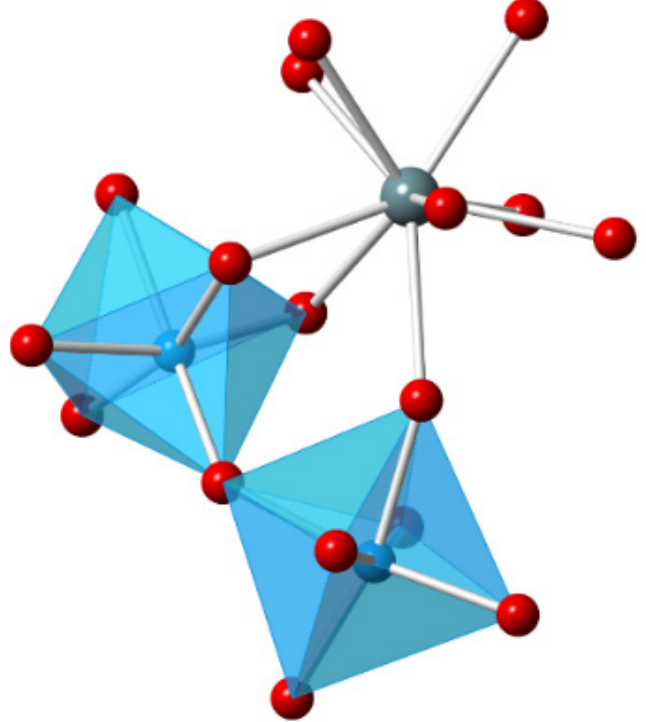
Figure 1. Hypothetical structure of an Am 3+ complex on corundum used for the FEFF calculations. The atom colors refer to Al in light blue, O in red, and Am in gray.